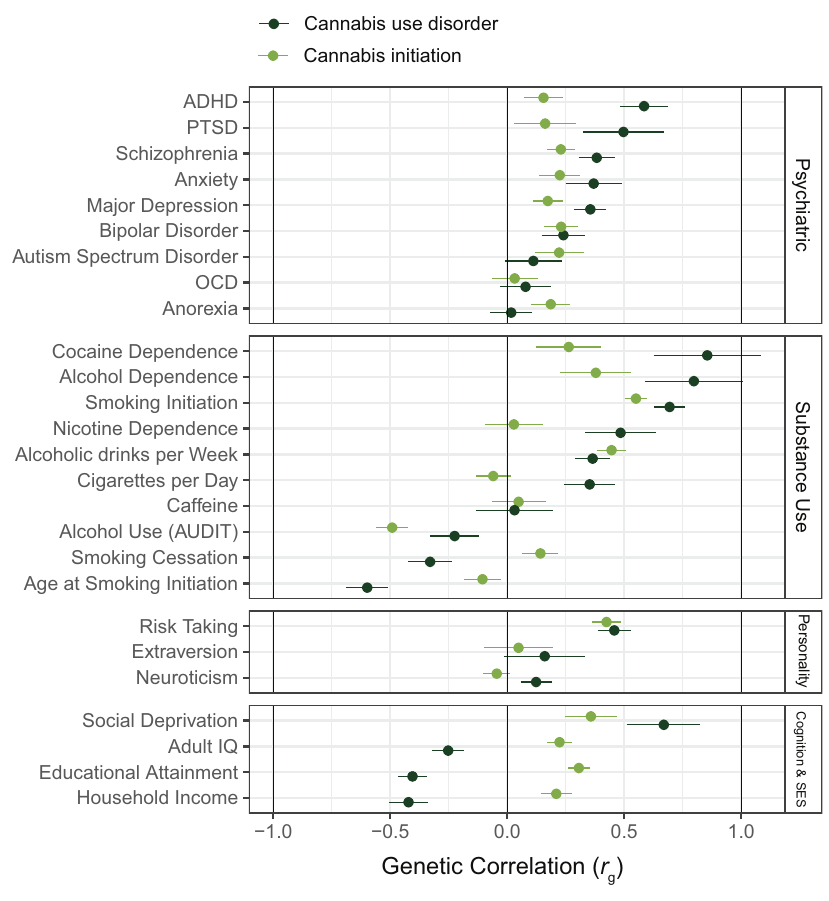
Fig. 2 Genetic correlations of cannabis initiation and cannabis use disorder with behavioral and mental health outcomes. The genetic correlations were computed with LD Score regression and the GWAS summary statistics of the GWASs on these traits (see Supplementary Table 1 for references and sample